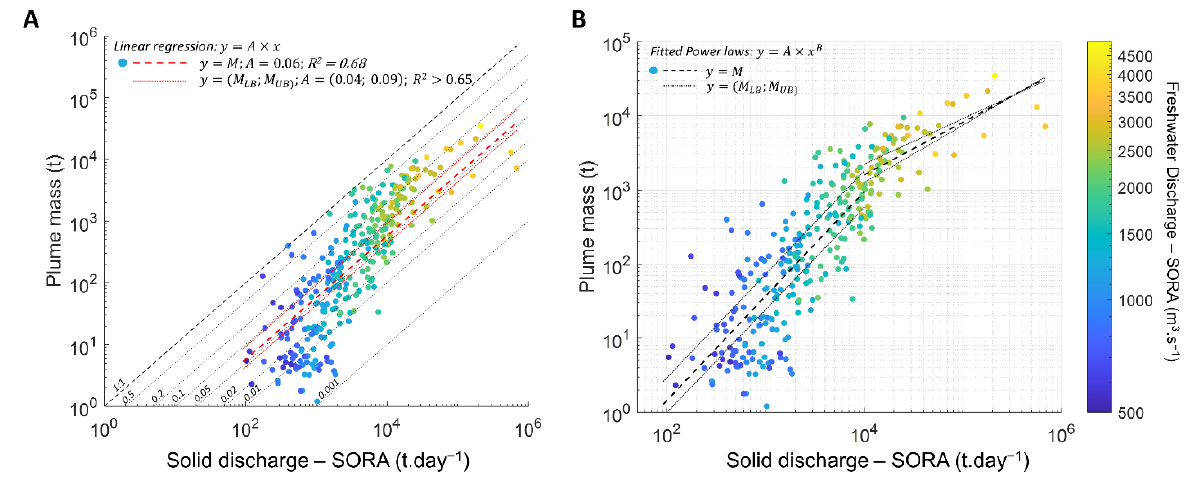
Figure 11. Relationship between the Rhône River solid discharge at the SORA station and SPM mass in the Rhône River plume computed using MODIS data (2014; 2015; 2016; 2018). ( A ) Data were first fitted with a linear regression (dashed line) and the slope was estimated after a logarithmic trans- formation of data ( log 10 (y) = A + log 10 (x) ). For comparison, lines with slope from 0.001 to 1 are also plotted (black dotted lines). ( B ) Data were then fitted with two power laws, one for solid discharges ranging from 100 to 10 4 t.day − 1 and the other one for higher river discharges (black dashed lines). For A and B coefficients, dotted lines represent regressions fitted for the plume SPM mass lower (LB) and upper bounds (UB). Table 4. Fitted coefficients for the relationships obtained between the Rhône River liquid and solid discharge and the SPM concentration at SORA and MesuRho, the plume surface, and the SPM mass (Figures 10 and 11). Coefficients for relationships obtained with the surface (SLB; SUB) and mass (MLB; MUB) lower and upper bounds are also indicated in parentheses (obtained with a plume boundaries SPM concentration threshold at 4 and 2 g.m − 3 , respectively). Fitted Power Law : 𝐲 = 𝐀 × 𝐱 𝐁 X